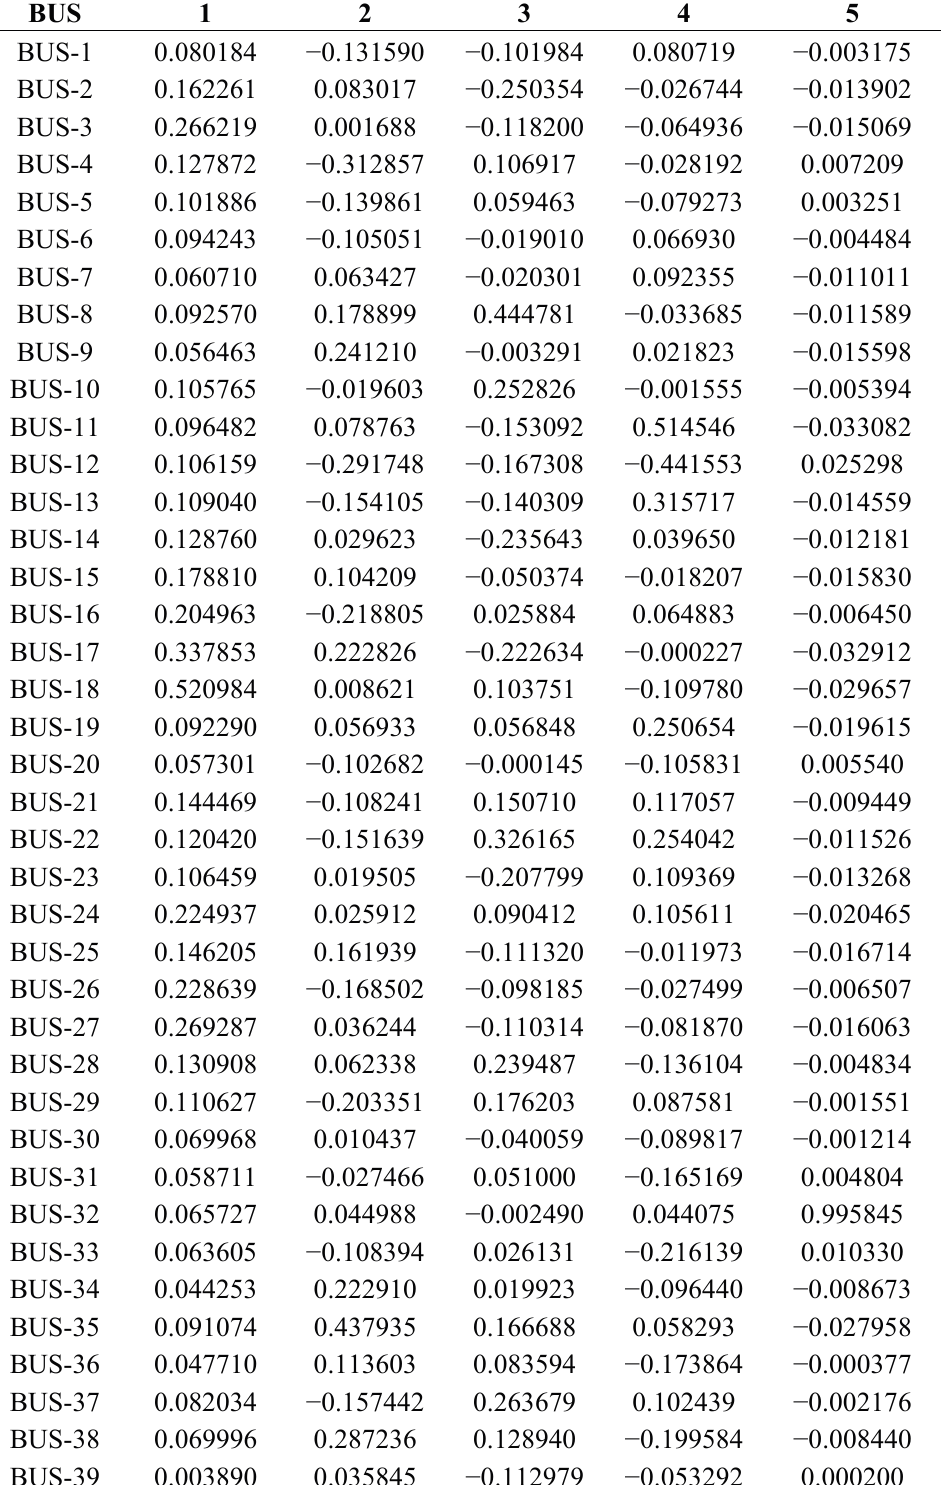
Table 2. The fault coefficient in asymmertical short circuit